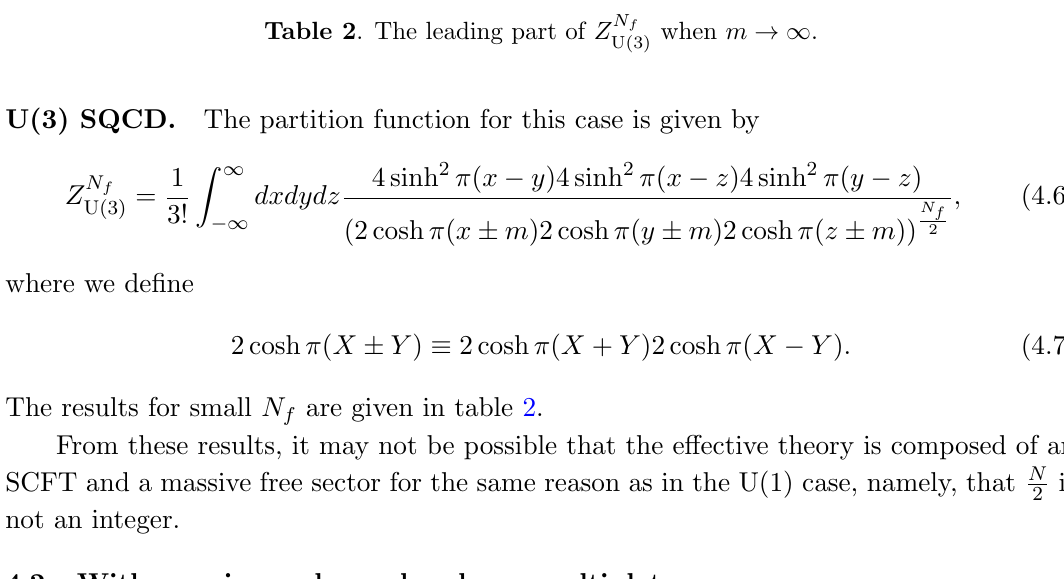
Table 2 . The leading part of Z N f